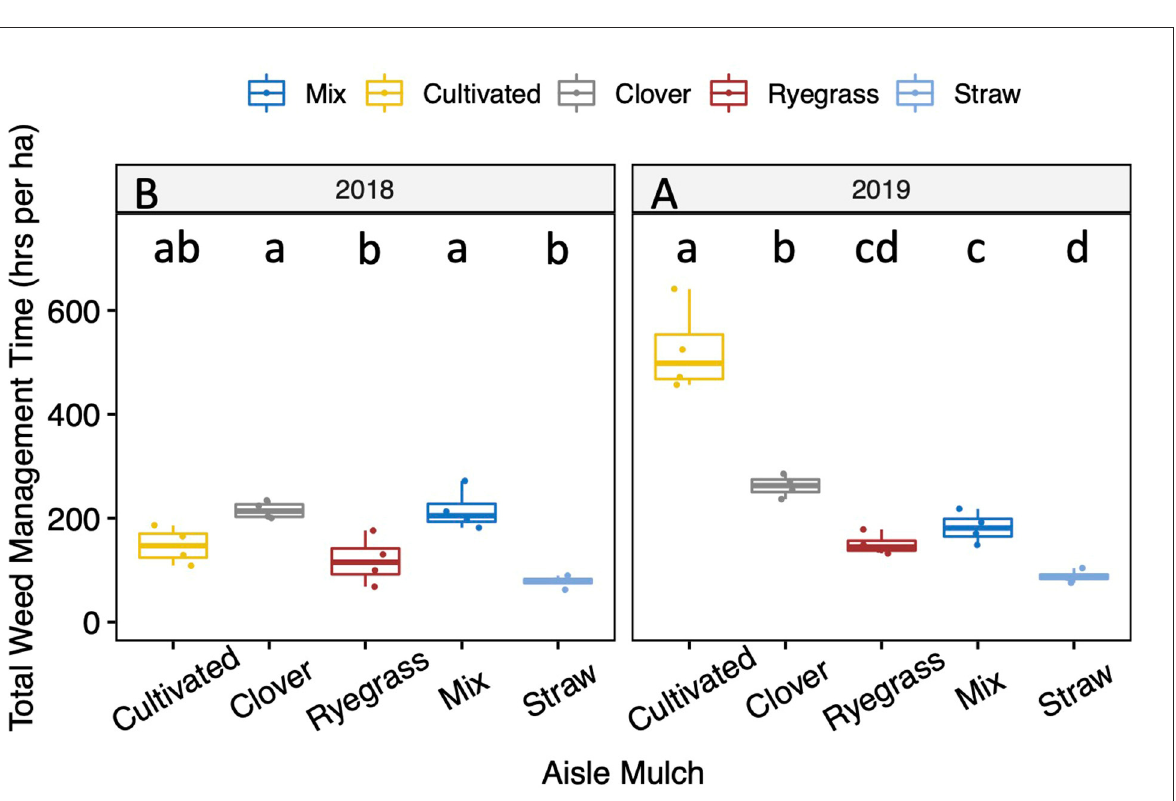
FIGURE7 Cumulative weed management time required for each living mulch cover crop treatment, 2018 and 2019. Lowercase letters indicate significance groupings within a given year and weed response variable, while uppercase letters indicate significance groupings for years across aisle mulch treatments. Groups that share the same letter are not significantly different at p < 0.05. Treatments that share the same letter are not significantly different at p <